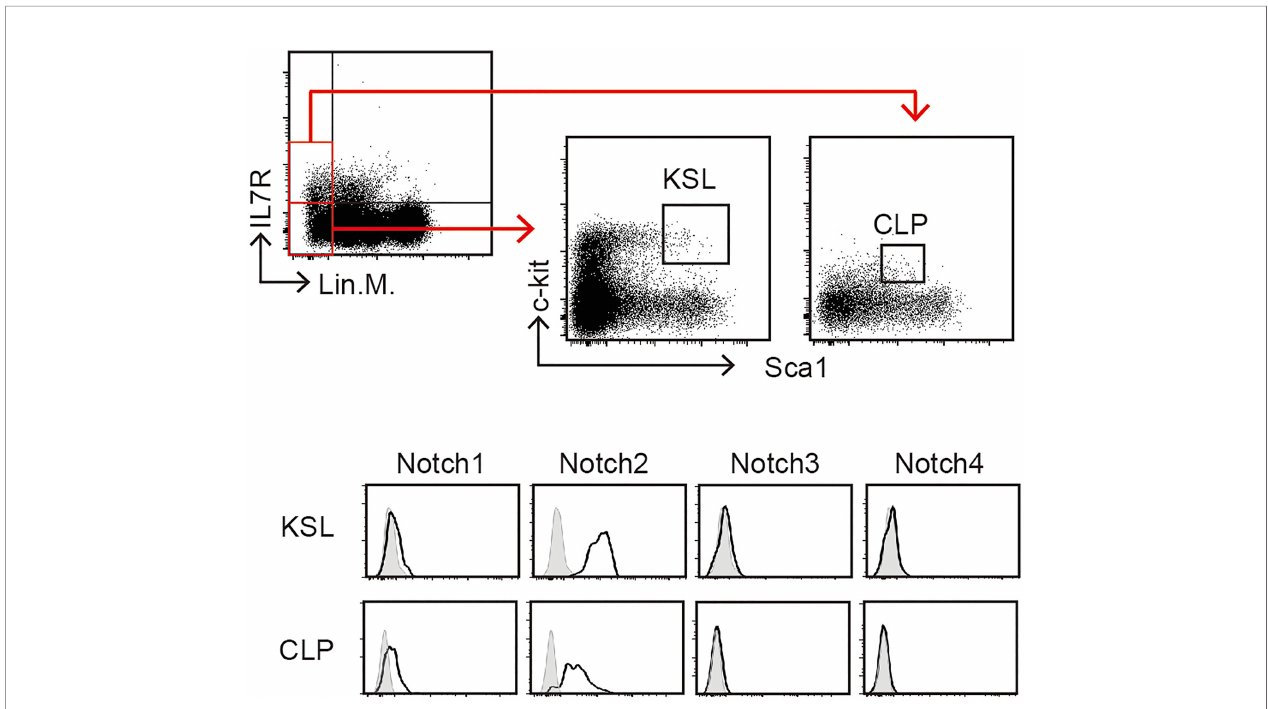
FIGURE 3 | Expression of Notch receptors on immature hematopoietic cells in the bone marrow. Bone marrow (BM) cells of C57BL/6 mice were subdivided into KSL (lineage markers - , c-kit + , and Sca1 + ) and CLP (lineage markers - , c-kit low , and Sca1 low ) populations (upper panels) and analyzed for Notch expression using fl ow cytometry (lower panels). Open histograms indicate staining with mAbs recognizing Notch1, Notch2, Notch3, or Notch4. Filled histograms indicate staining with control hamster IgG. These pro fi les represent at least three independent